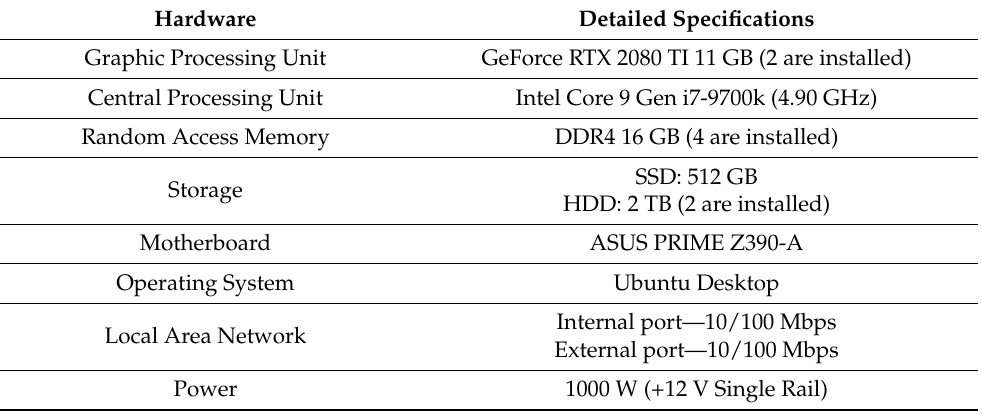
Table 3. AI server specifications.